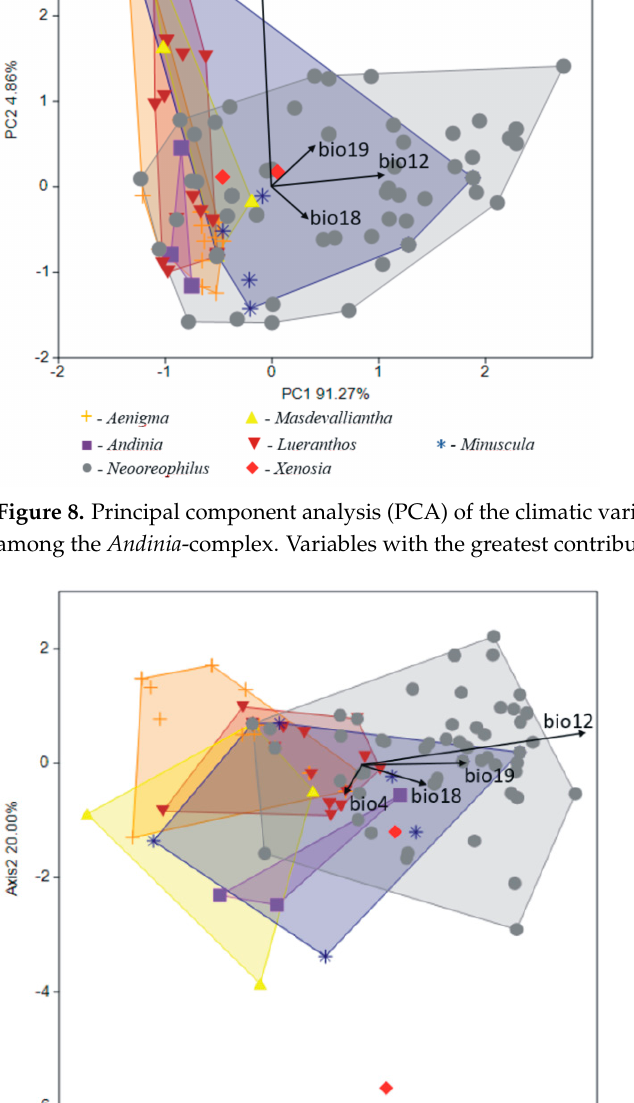
Table 2. Variables fitted to the PCA analysis focusing on climatic niche similarity of the studied species and determination coefficients ( R 2 ), where level of significance is marked (ns—not significant; *— p < 0.05; **— p < 0.01; ***— p < 0.001). Variables PC1 PC2 R 2